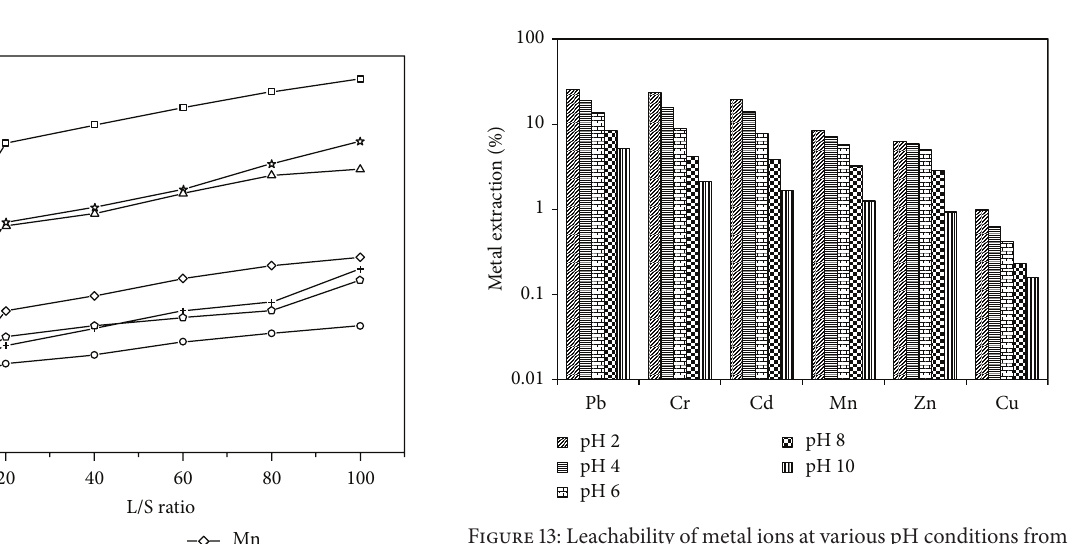
Figure 10: Cumulative percentage of various elements leached from NFA.